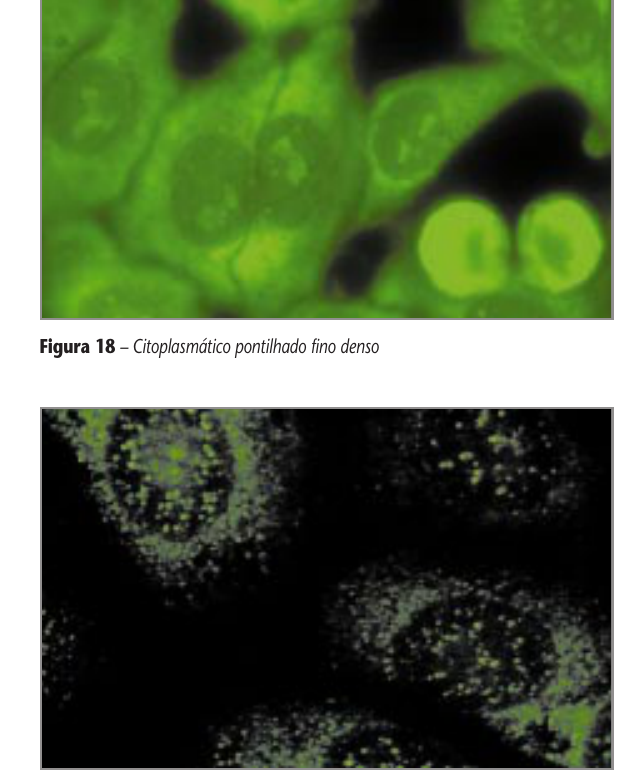
Figura 19 – Citoplasmático pontilhado